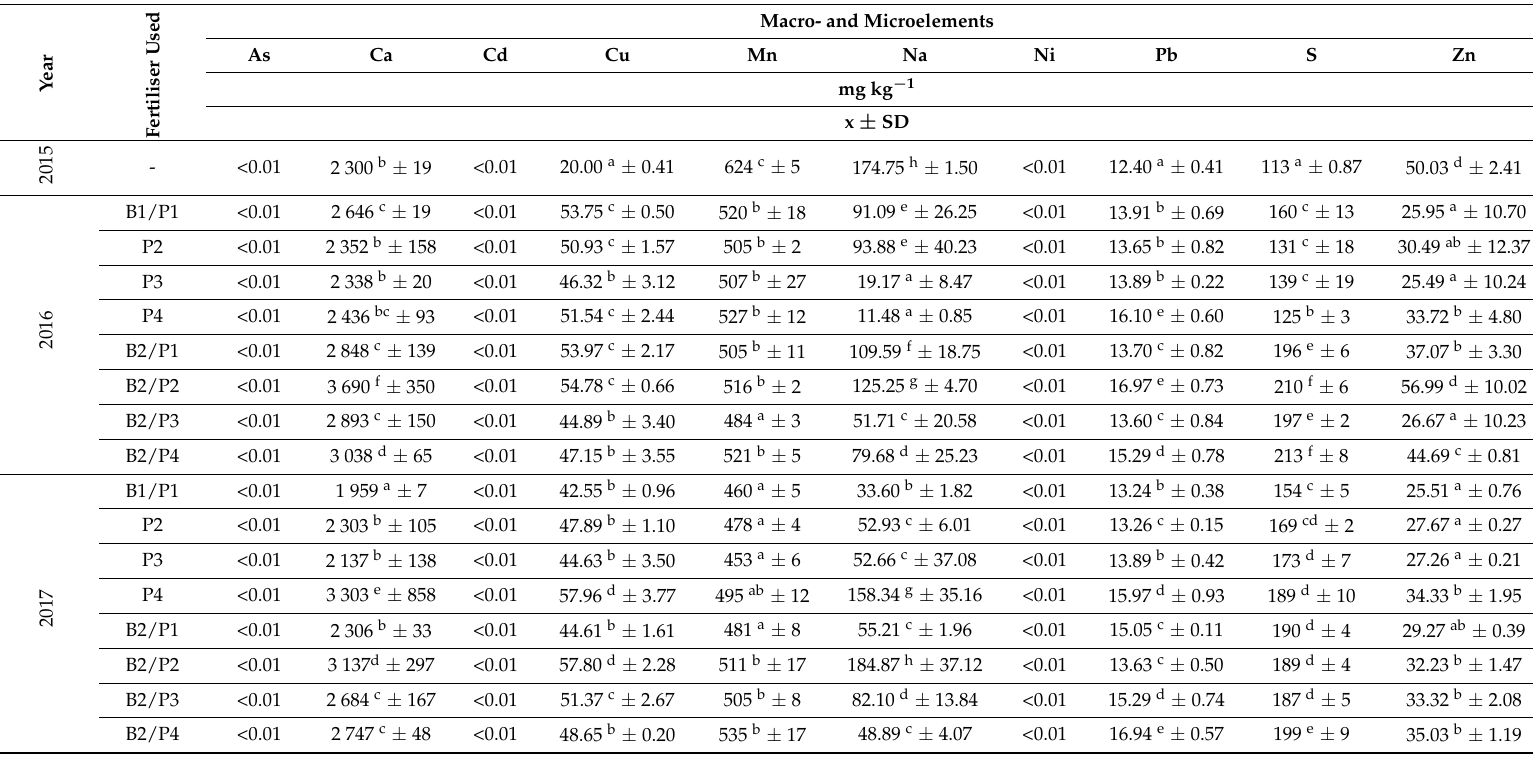
Table 4. Contents of selected macro- and microelements and heavy metals in the soil before the experiment and after the first and second year of cultivation, depending on the fertiliser